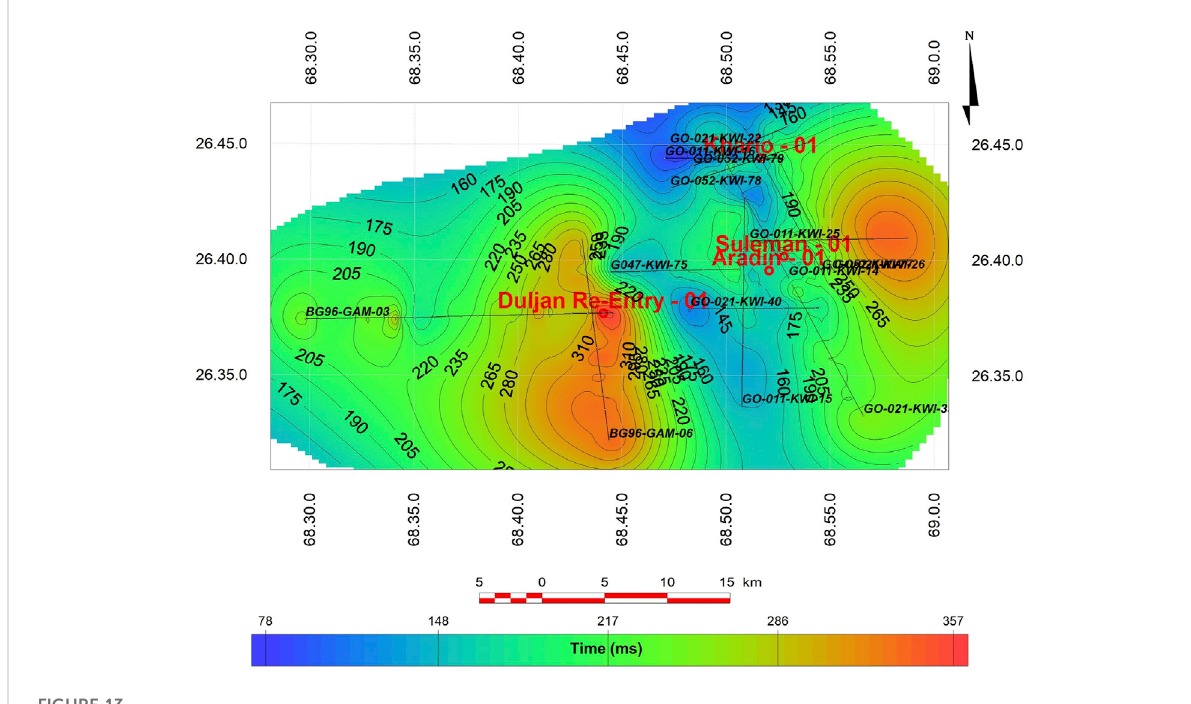
FIGURE 13 Isochron map of sands of the Sembar Formation (blue shows minimum thickness, whereas red shows maximum